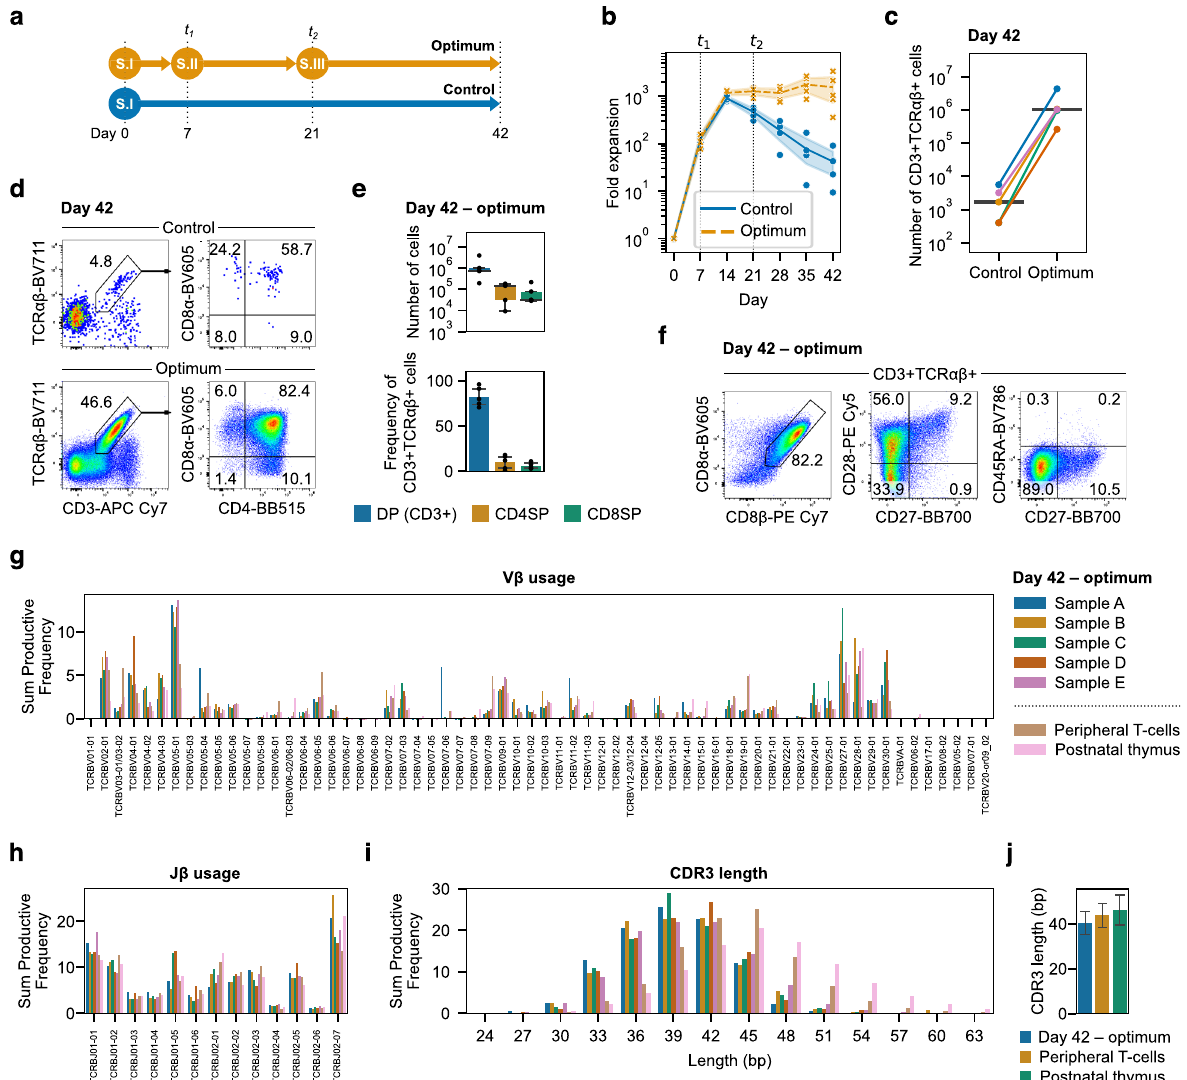
Fig. 5 Optimized cytokine concentrations provide stage-speci fi c signals during T-cell development. a The three-stage optimum cytokine concentrations were compared to a control that used the fi rst stage concentrations throughout the entire differentiation. All other parameters (seeding density, passage ratio, schedule, etc.) were kept the same for each condition. b Fold expansion over 42 days using the optimized three-stage assay. Cytokine concentrations were changed at t 1 and t 2 . Lines represent the mean over time for each condition and the shaded areas are the 95% con fi dence intervals. c Absolute count of CD3 + TCR αβ + cells on day 42 from 2000 HSPCs seeded per well on day 0. Lines connecting control and optimum are from the same UCB donor and the horizontal line is the median for each condition. d On day